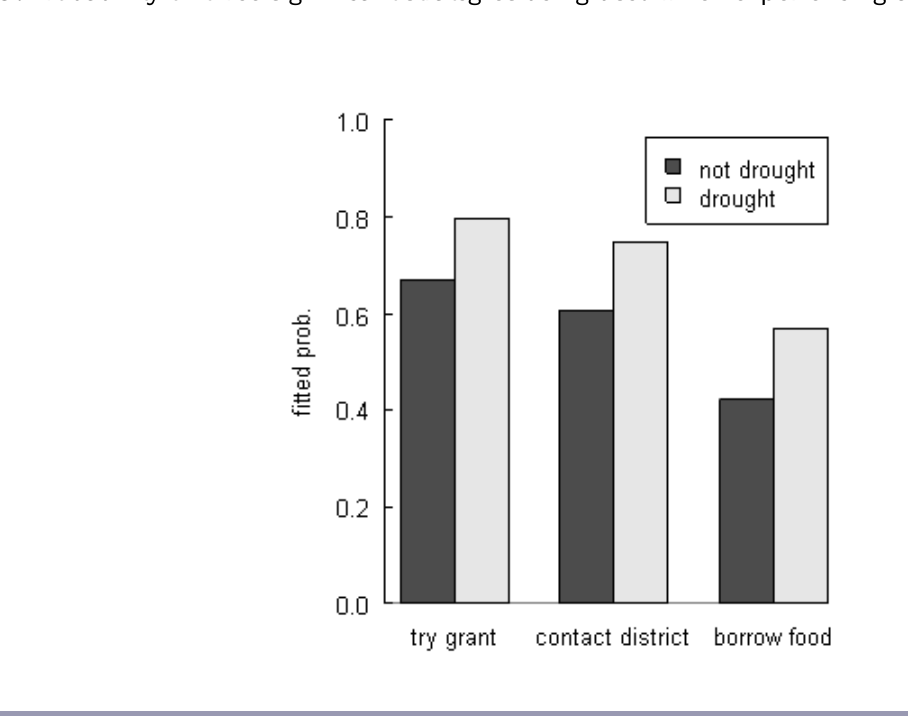
Fig. 3. Probability of three significant strategies being used when experiencing a